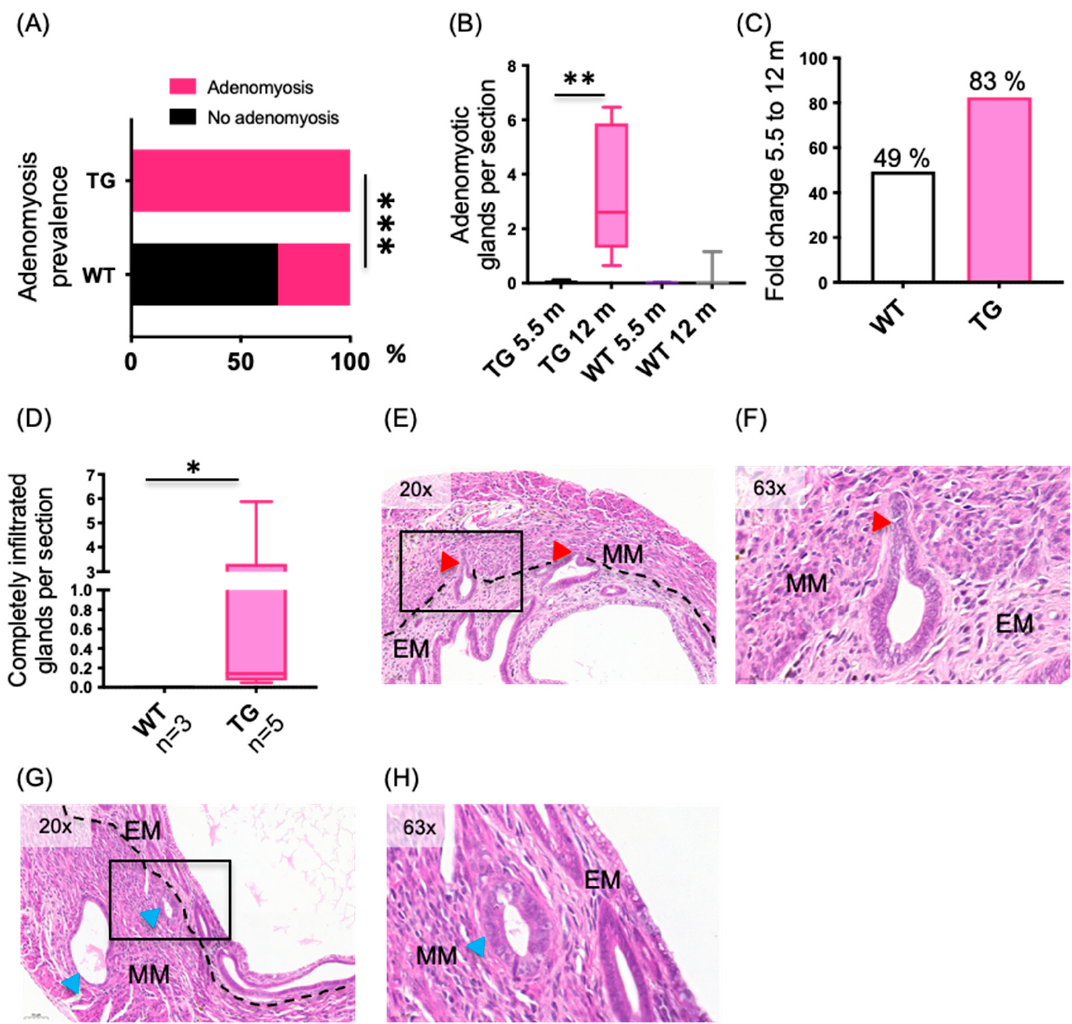
Figure 4. Increased amount of adenomyotic changes in HSD17B1TG mice at the age of 12 months. ( A ) When 43–57 serial sections per mice were analyzed, 100% of the HSD17B1TG females presented with adenomyotic changes at the 12 months of age ( n = 5), while the changes were observed in 33% of the WT mice ( n = 3). ( B ) Significantly increased numbers of adenomyotic glands per analyzed sections were observed in 12-month-old HSD17B1TG mice compared to the 5.5-month-old mice, whereas in WT mice, there was no difference between the two age groups. ( C ) The difference in the amount of adenomyotic glands between the HSD17B1TG and WT mice increased from 5.2-fold at the 5.5 months to 8.8-fold at the at the age of 12 months. ( D ) The number of adenomyotic glands completely infiltrated into the myometrium was significantly increased in HSD17B1TG mice compared to WT mice at the age of 12 months. ( E ) A cross-section of HSD17B1TG uterus showing partially infiltrated glands with invasive epithelial structures. ( F ) A higher magnification of ( E ). ( G ) A cross-section of HSD17B1TG uterus showing completely infiltrated glands. ( H ) A higher magnification of ( G ). * p < 0.05, ** p < 0.01, *** p < 0.001, EM = endometrium, MM = myometrium, red arrowheads = partially infiltrated glands, blue arrowheads = completely infiltrated glands, black squares = the areas shown in higher